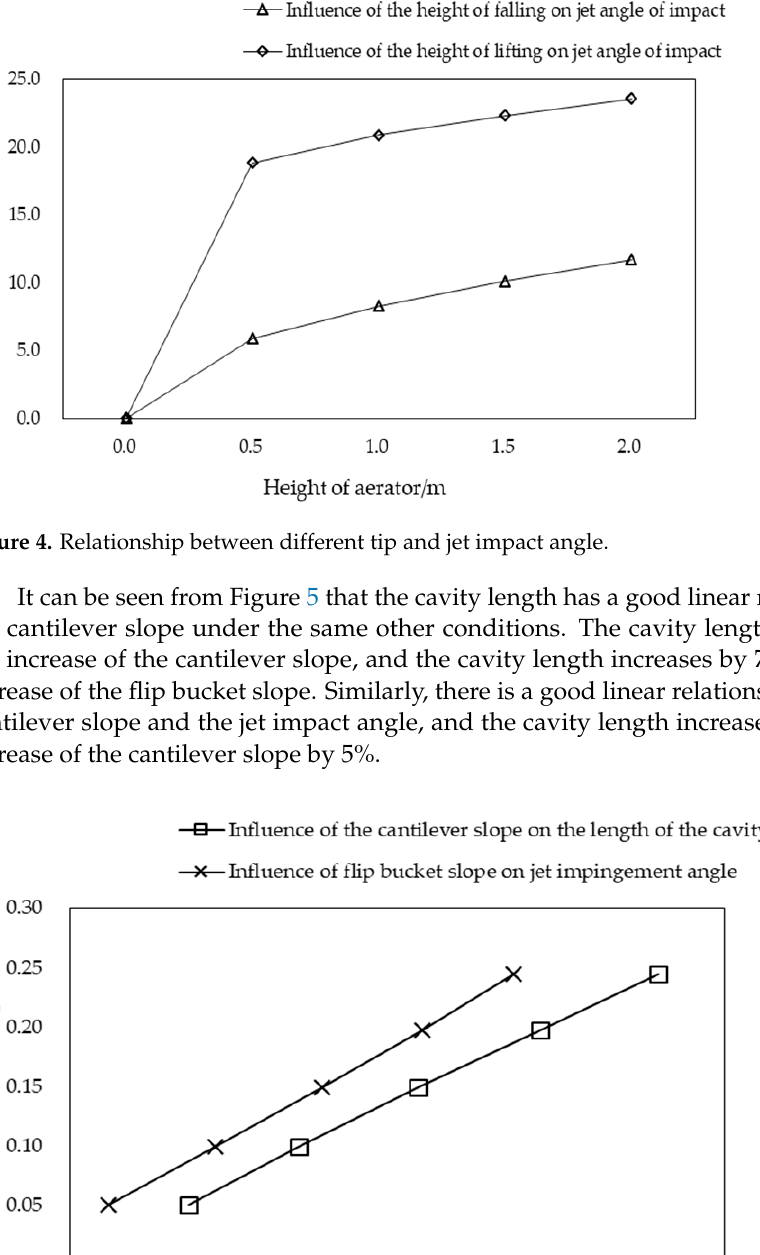
7 of 13 Table 2. Theoretical calculation and analysis of body type group table. Group